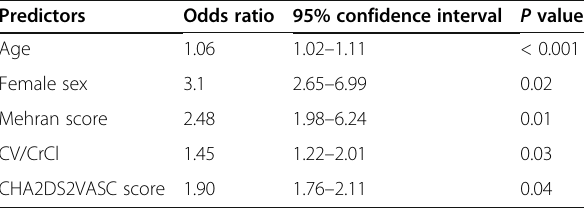
Table 5 Predictors of CIN among the studied patients